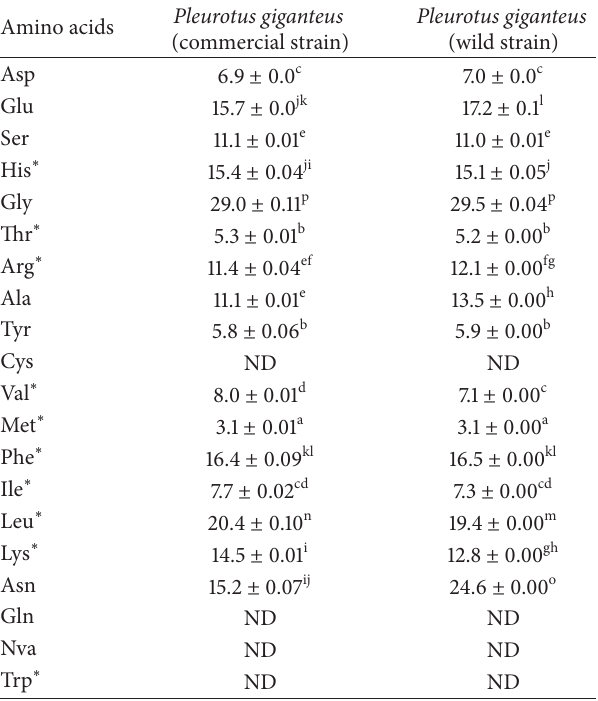
Table 2: Amino acid content (g kg − 1 protein) of Pleurotus giganteus KLU-M 1227and KLU-M 1228. Amino acids